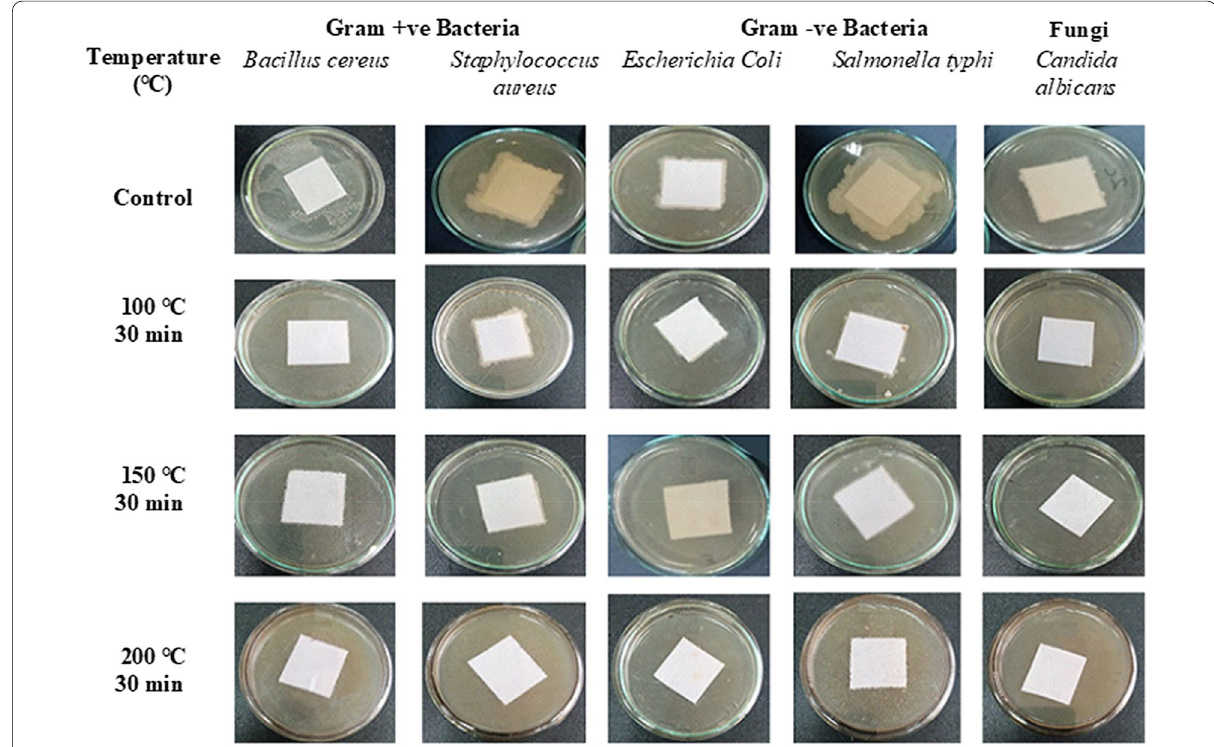
Fig. 5 The efficiency of dry heating for 30 min in the sterilization of pathogenic contaminated